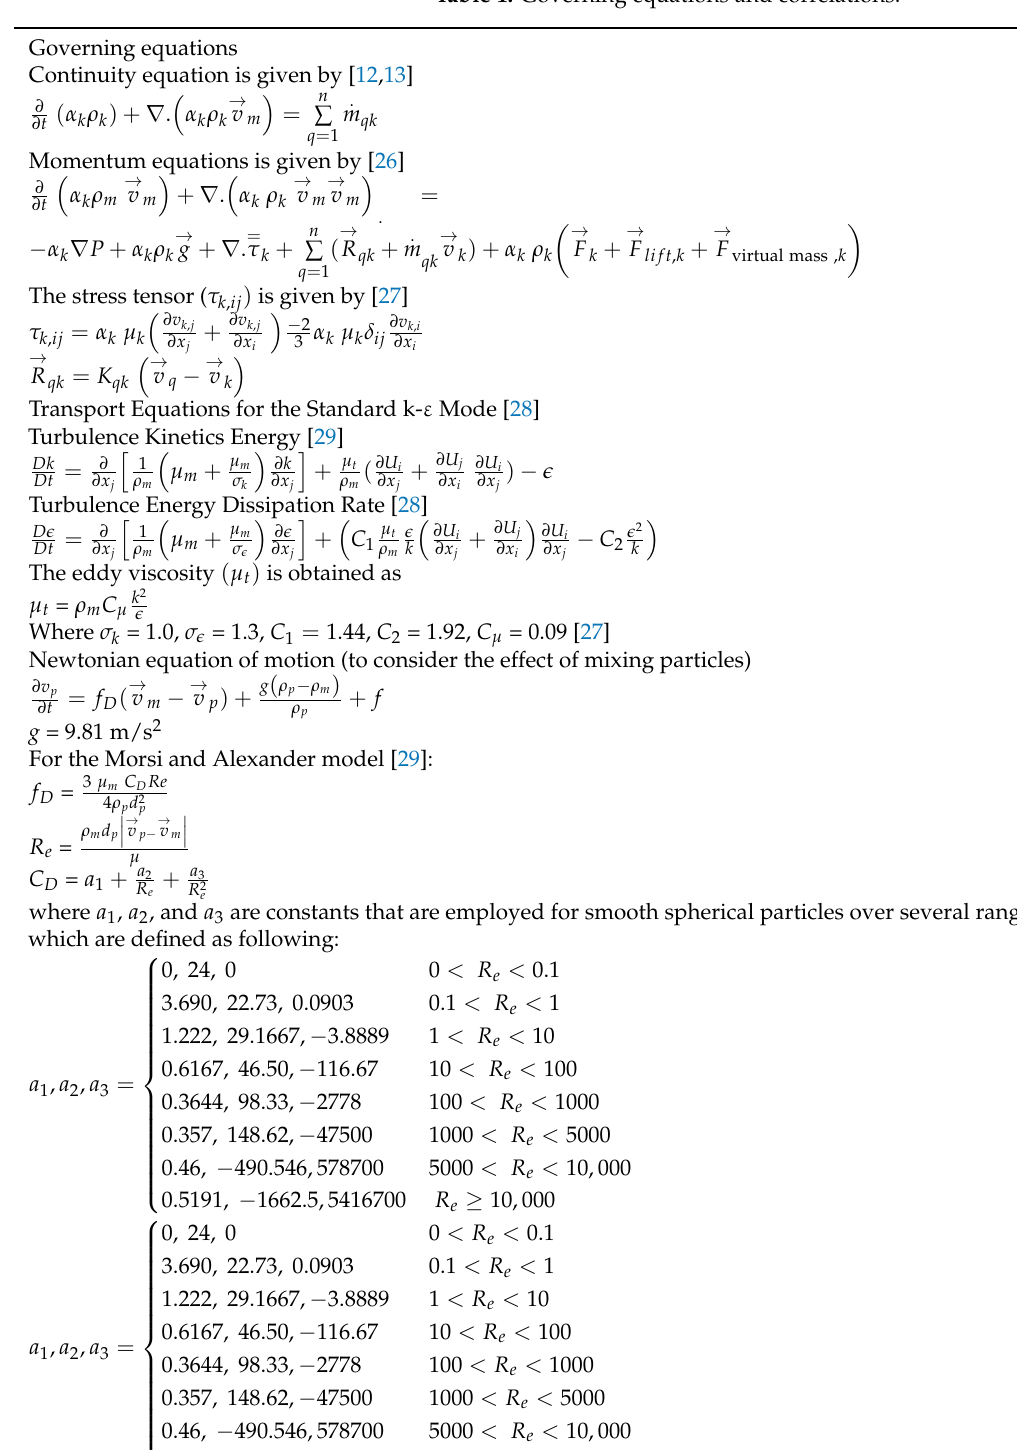
Table 1. Governing equations and